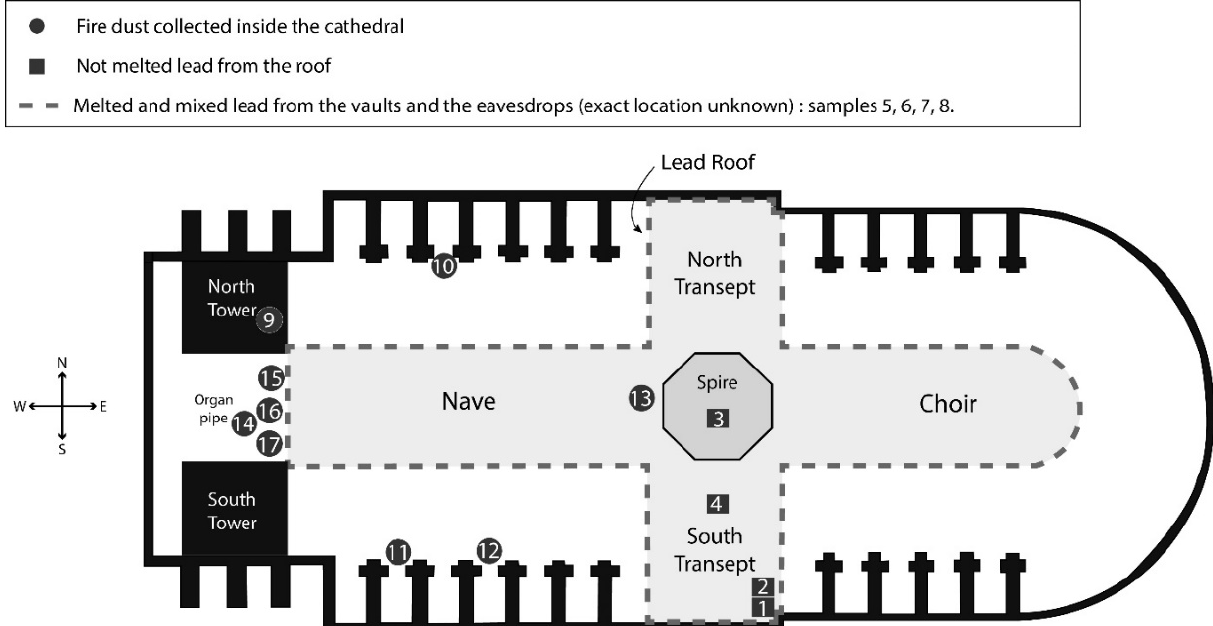
Figure 1. Location and nature of the samples, Notre Dame de Paris cathedral, 2020.